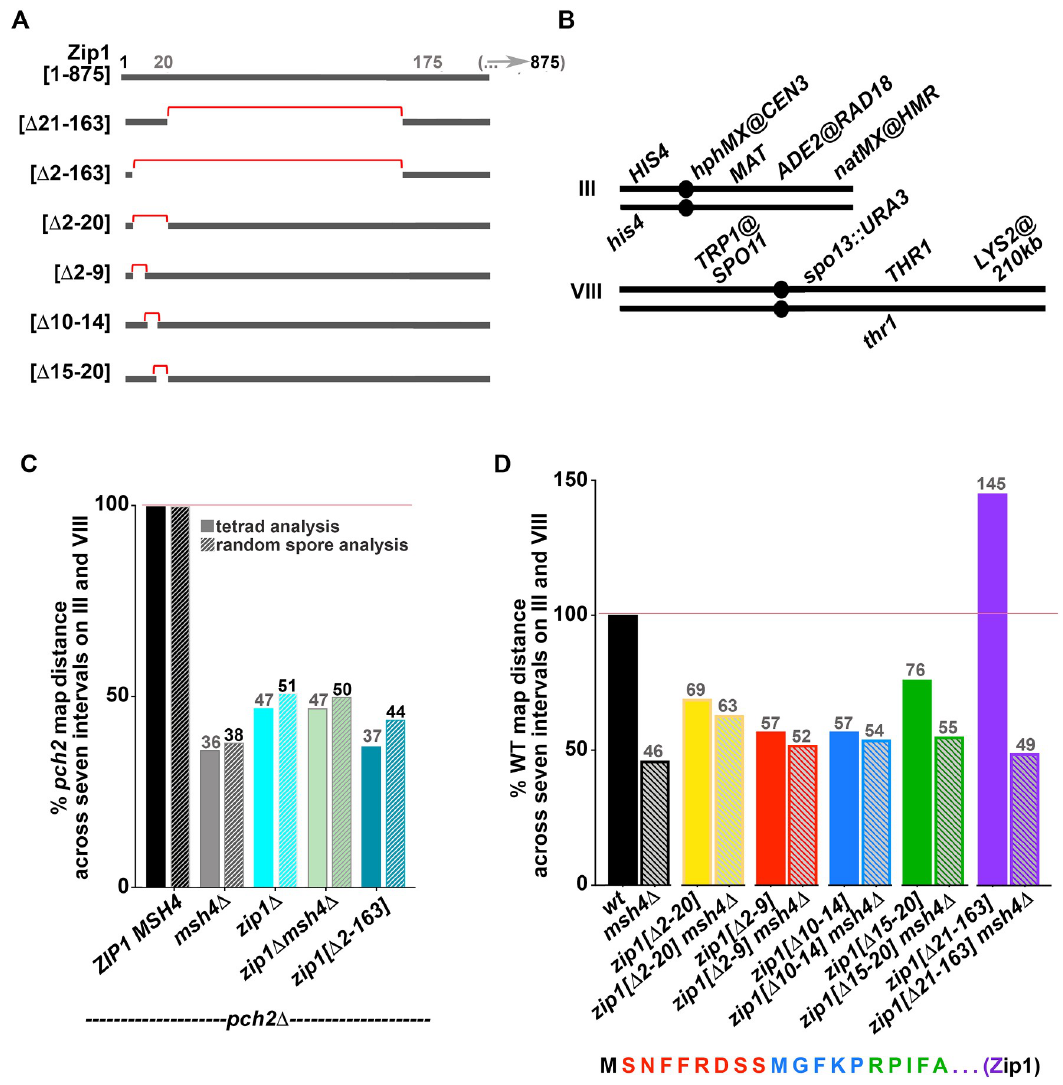
Fig 1. Zip1’s N terminal twenty residues are critical for MutS γ crossing over. A) Line illustrations represent Zip1’s N terminal region (approximately residues 1–200); red brackets highlight residues that are deleted in the altered versions of Zip1 analyzed in this study (precise deletion information is indicated at the left of each line). B) Cartoons illustrate the seven genetic intervals that were utilized to assess meiotic crossover recombination in this study; strains carried two distinguishable alleles (genetic markers) corresponding to five loci whose position span the length of chromosome III, and four loci whose positions encompass more than half of chromosome VIII. Crossover recombination is measured by examining the frequency of chromatids for which adjacent genetic markers have become unlinked from one another during meiosis; a higher frequency of crossover recombination results in a larger map distance between genetic markers that define an interval. ( C, D ) Bar graphs plot the sum of map distances across all seven intervals in each strain, normalized to the control value. Note that the control for normalization in ( C ) is the pch2 value, while wild type is the control in ( D ). Random spore analysis was used to calculate the map distances shown in the hatched bars graphed in (C) , while tetrad analysis was used to calculate the map distances illustrated by the solid bars in (C, D) ; see Materials and methods for map distance calculation procedures. Exact values corresponding to % of control map distances are indicated in gray color above each bar in ( C, D ). Map distances for individual intervals are reported in Table 1 ( pch2 strains) and Table 2 ( PCH2 strains). pch2 strains used in ( C) are: AM3724 ( ZIP1 MSH4 ), AM4025 (msh4 ), AM4023 ( zip1 ), AM4026 ( zip1 msh4 ), AM3725 ( zip1[ Δ 2–163]) . Strains used in ( D) are: K842 ( wt ), K852 ( msh4 ), AM3684 ( zip1[ Δ 2–20]) , K1000 ( zip1[ Δ 2–20] msh4) , MP43 ( zip1[ Δ 2–9]) , MP46 ( zip1[ Δ 2–9] msh4) , SYC107 ( zip1[ Δ 10–14]) , SYC149 zip1[ Δ 10–14] msh4 , AF8 ( zip1[ Δ 15–20]) , K914 ( zip1[ Δ 15–20] msh4) , AF6 ( zip1 [ Δ 21–163]) , and SYC151 ( zip1[ Δ 21–163] msh4) . Data for wild-type, msh4 , zip1[ Δ 21–163] , and zip1[ Δ 21–163] msh4 strains were reported previously [24]. Zip1’s first twenty amino acid residues are illustrated below the graph in ( D ), with colors corresponding to the residues removed in each of three zip1 mutant alleles: red = zip1[ Δ 2–9] , blue = zip1[ Δ 10–14] , green = zip1[ Δ 15–20]